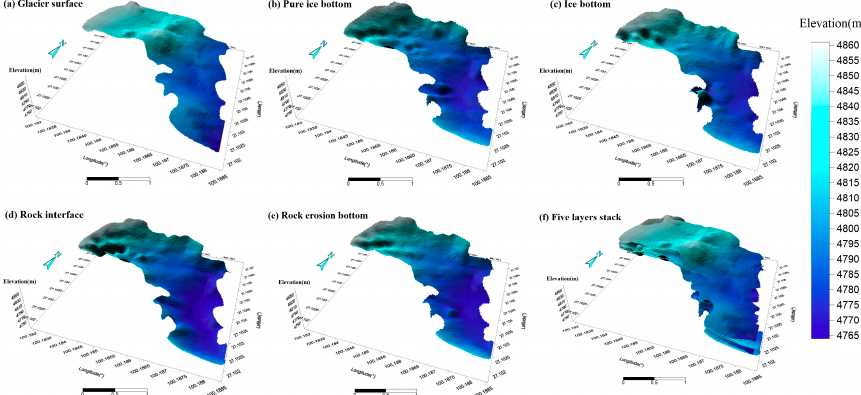
Figure 7. Ice thickness contours in the mid-part of BRG1 in Mt. Yulong. Combined with SRTM DEM of BRG1, based on the bedrock topography surface data derived by kriging interpolation, we obtained grid data of the bedrock surface elevation. The bedrock terrain contour map of this region with a gradient of 5 m is drawn in Figure 8. In addition to the glacier surface terrain based on the GPS measured data, the same method was used to obtain the surface topography of the other three layers and the three-dimensional (3-D) image of the subglacial five- layer structure of the BRG1 (Figure 9). The thickness shows ice ridges below the glacier surface at 4780 m a.s.l., the bedrock there shows a slight sunken landform with a circular concave in the center, which is consistent with the shape of the glacier bottom from the GPR ice thickness profiles (Figure 5b). Figure 8. ( a ) The bedrock surface topography under the mid-part of BRG1 in Mt. Yulong. ( b ) The bedrock topography contour map of the mid-part of BRG1 in Mt. Yulong.